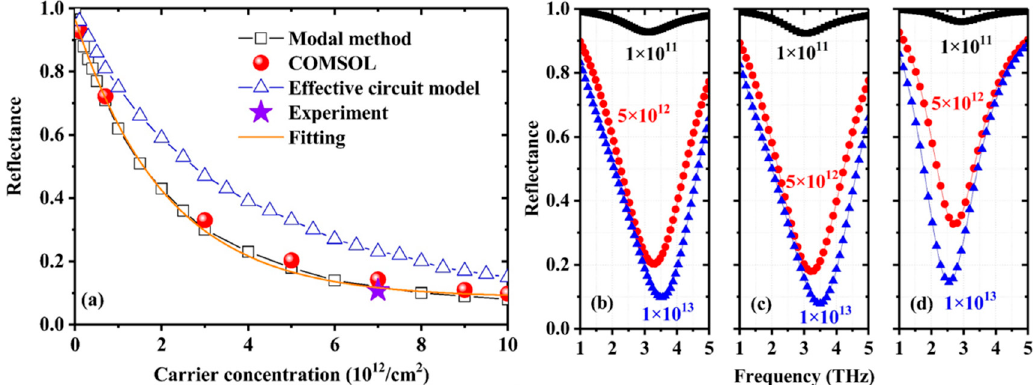
Figure 3. Calculated reflectance of the first dip with different carrier concentrations in the graphene sheet using FEM, MM, and ECM ( a ), and reflection spectra for carrier concentrations of 1 × 10 11 /cm 2 , 5 × 10 12 /cm 2 , and 1 × 10 13 /cm 2 in the graphene sheet calculated by using FEM ( b ), MM ( c ), and ECM ( d ).